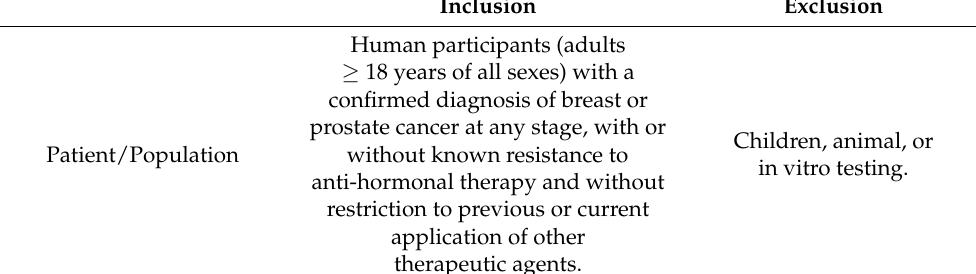
Table 1. Structured overview of inclusion and exclusion criteria according to the “Patient/Population, Intervention, Comparison/Control, Outcome, Study design” (PICOS)